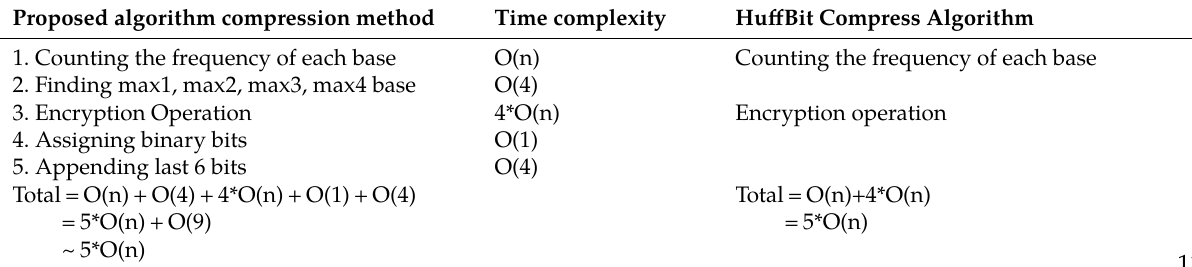
Table 2: Time complexity of proposed algorithm and ‘ HuffBit Compress Algorithm ’